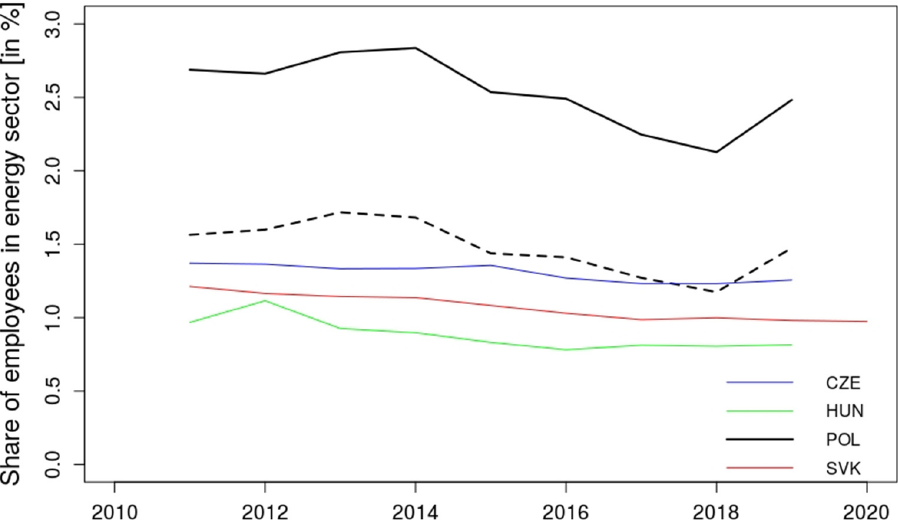
Figure 13. Share of employment in the energy sector vs. all employment (2011–2019/2020). NACE classification, employment in the sectors ‘electricity, gas, steam and air conditioning supply’ and ‘mining’ (also shown separately as dashed line). Source: EUROSTAT [38].